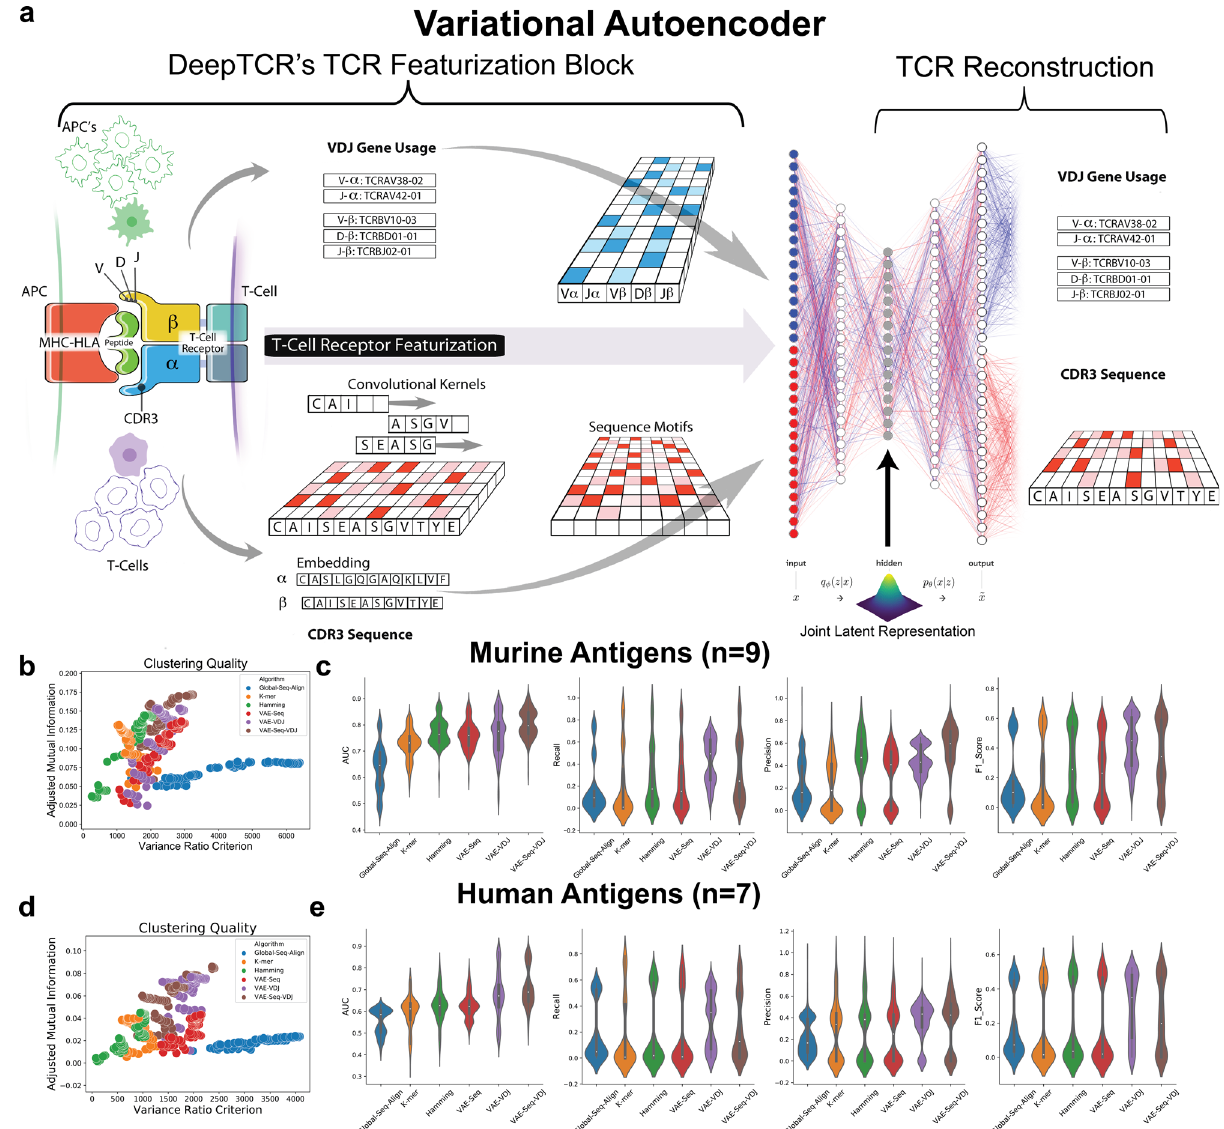
Fig. 1 Unsupervised TCR sequence representation. a In order to represent a T cell receptor (TCR) we have implemented a variational autoencoder (VAE) to take the CDR3 sequences from both the α - and β -chains along with their corresponding V, D, and J gene usage and learn a joint representation of these inputs. The CDR3 sequences serve as input to the encoder side of the network where convolutional layers are then applied to learn sequence motifs from these regions. As for the V/D/J gene inputs, these are represented as categorical variables which are then transformed with a trainable embedding layer to learn a continuous representation of the gene usage of a given TCR. Finally, these inputs are concatenated together passed through fully connected layers to result in the latent representation of the TCR. This latent representation is then sampled from in order to reconstruct the input CDR3 sequences and V/D/J genes through the decoder side of the network. Finally, the weights of the neural network are trained via gradient descent to jointly minimize both the reconstruction and variational loss. The trained network is then used to take a given TCR and represent it in a continuous numerical domain for downstream analysis such as clustering. b , d In order to assess the quality of various methods of TCR featurization, we derived TCR distances from the various featurization methods (VAE-Seq, VAE-VDJ, VAE-Seq-VDJ, Hamming, K-mer, Global-Seq-Align) and applied an agglomerative clustering algorithm varying the number of clusters evenly from 5 to 100 and measured the variance ratio criterion of the clustering solutions and the adjusted mutual information from the clustering solutions to the ground truth antigen labels for both nine murine and seven human antigens. Featurization methods that encourage high-quality clusters that capture a high degree of information of the label (i.e. antigen speci fi city) should have a high variance ratio criterion and high adjusted mutual information. c , e In order to benchmark the ability of various methods of TCR featurization to correctly classify a TCR sequence to its antigen, we applied a K -Nearest-Neighbors instance-based classi fi cation algorithm (varying K evenly from 1 to 500, Supplementary Figs. 3 – 10) to the derived TCR distances on the nine murine and seven human tetramer-sorted antigen-speci fi c T cells and assessed classi fi cation performance via fi vefold cross-validation strategy, measuring AUC, Recall, Precision, and F 1 Score. Illustrations for Panel a provided by Tim Phelps Copyright 2020 JHU AAM,